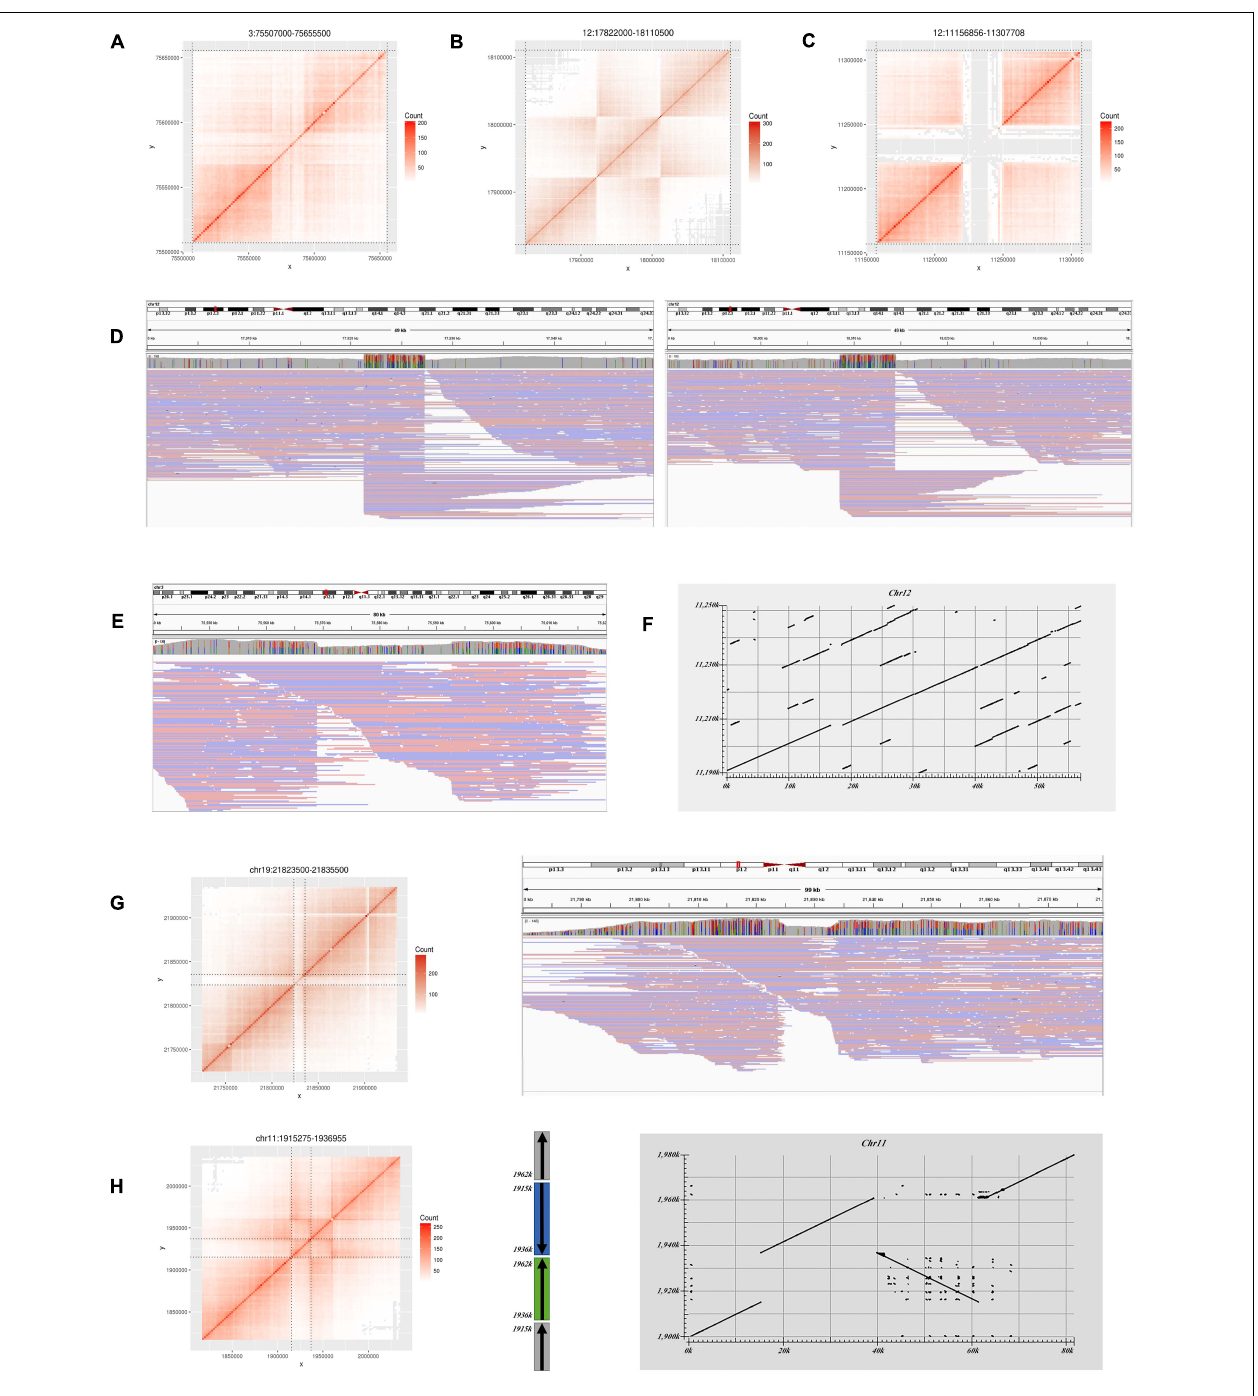
FIGURE 3 | Large variations do not match the GIAB benchmark in HG002. (A) Heatmap for a deletion on Chr3. (B) Heatmap for an inversion on Chr12. (C) Heatmap for a deletion on Chr12. (D) Long read alignment supports the inversion in (B) . (E) Long read alignment supports the deletion in (A) . (F) Assembly alignment to reference by Blast for the deletion in (C) . (G) Heatmap for a deletion on Chr19 and long read alignment. (H) Heatmap and structure for an inversion on Chr11 and assembly alignment.